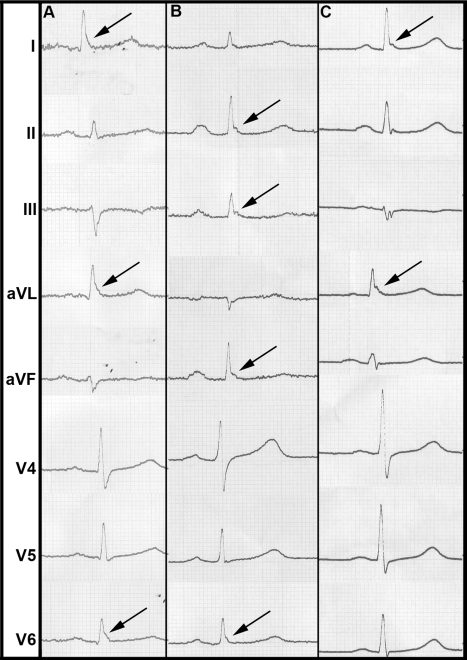
Representative examples of ERP from our study population.(A) shows a slurring morphology, whereas a notching morphology predominates in (B) and (C). Arrows point to leads where ERP can be identified most clearly.